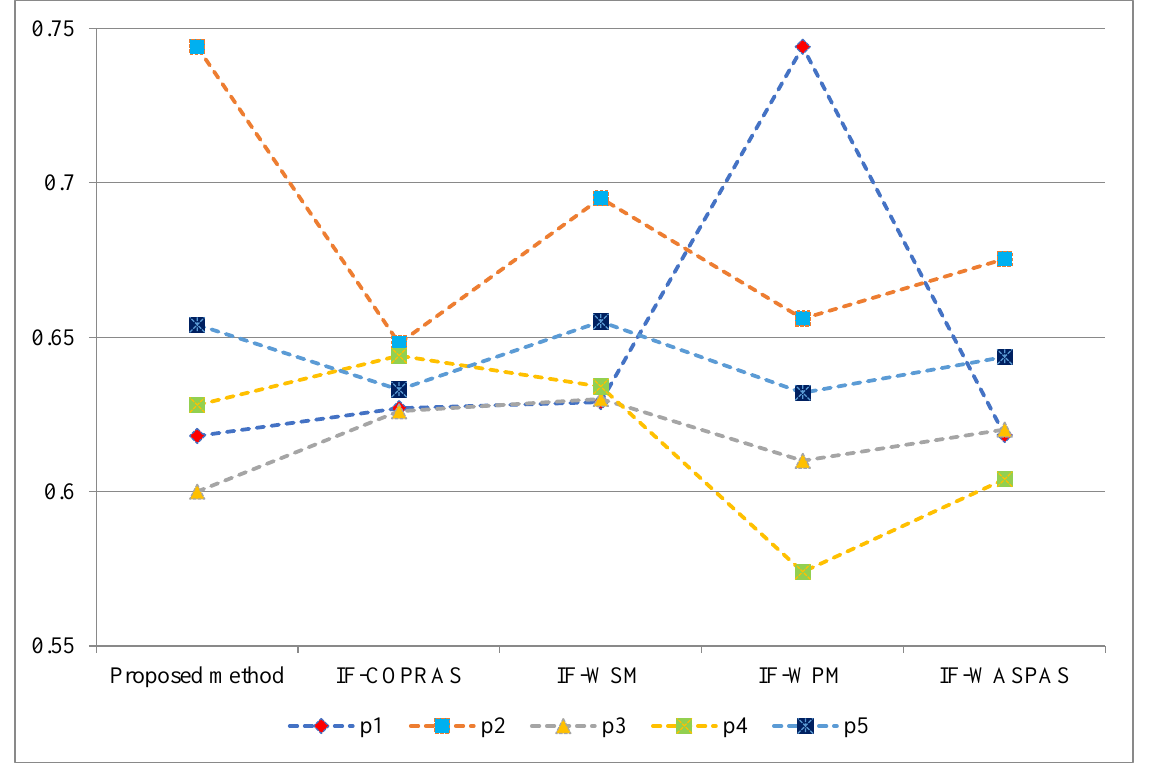
Figure 3. Ranking order when we were prioritizing the BESSs using different methods.